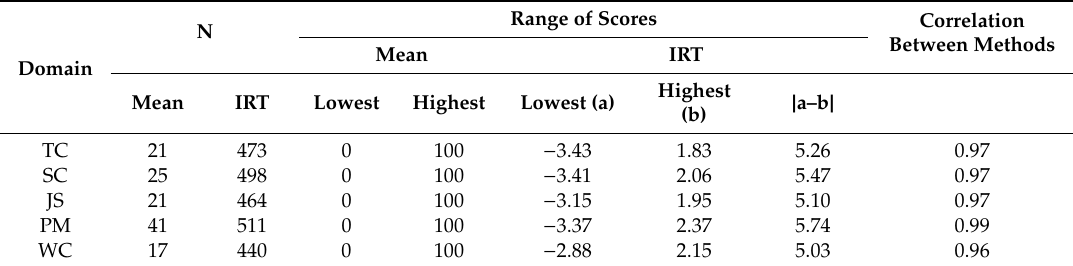
Table 2. Comparison between traditional mean and IRT scores. (TC: teamwork climate, SC: safety climate, JS: job satisfaction, PM: perception of management, WC: working condition, IRT: item response